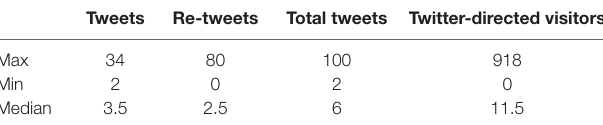
Table 3 | Statistical